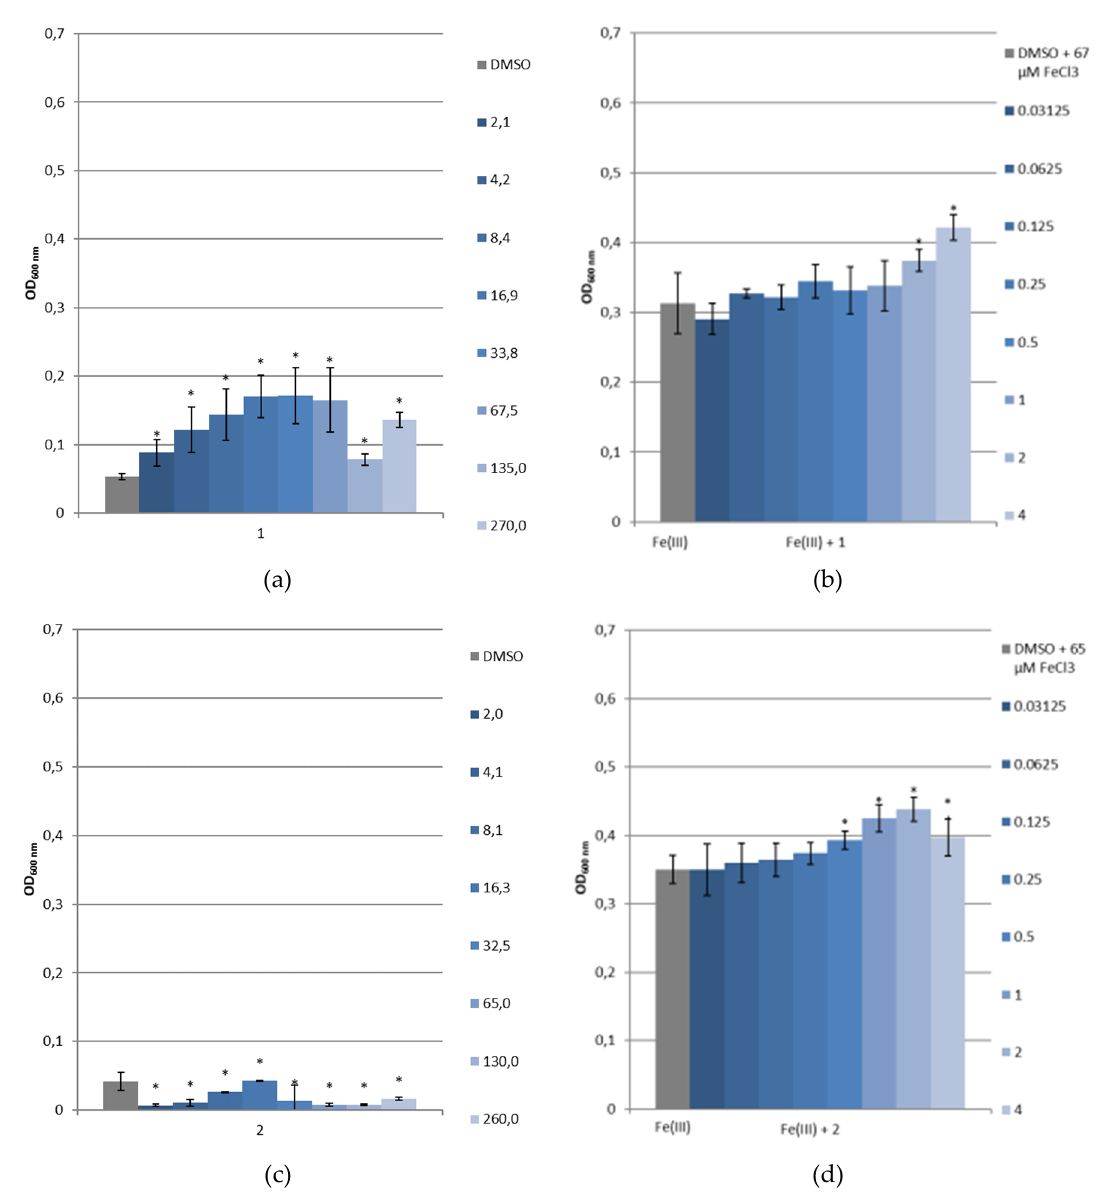
Figure 11. Growth of P. aeruginosa PAD07 in SMM ( a ) without ferric iron and with 1 , ( b ) with ferric iron and with 1 , ( c ) without ferric iron and with 2 or ( d ) with ferric iron and with 2 . Values given in the caption at the right of the histograms indicate for ( a ) and ( c ) the [ L ] concentration in μM and for ( b ) and ( d ) the [ L ]/[Fe(III)] molecular ratios. *: p < 0.05 (vs. control, Mann–Whitney test).